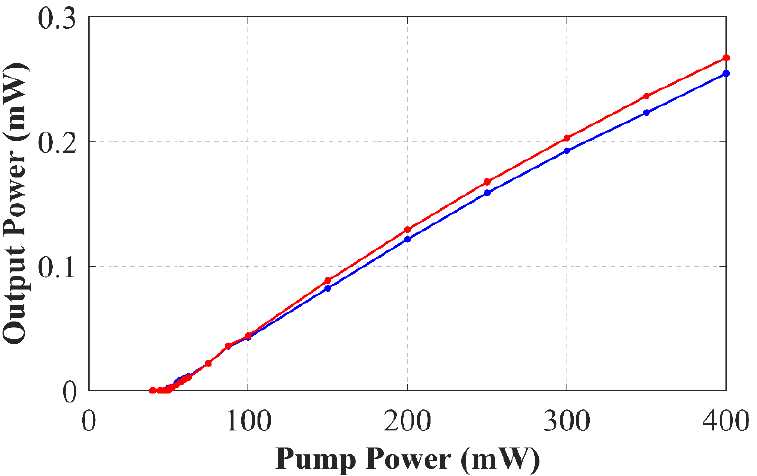
Figure 6. Relationship between the output power levels versus 976-nm pump power for the 1527.7 nm (blue line) and 1530.81 nm (red line) emission lines.